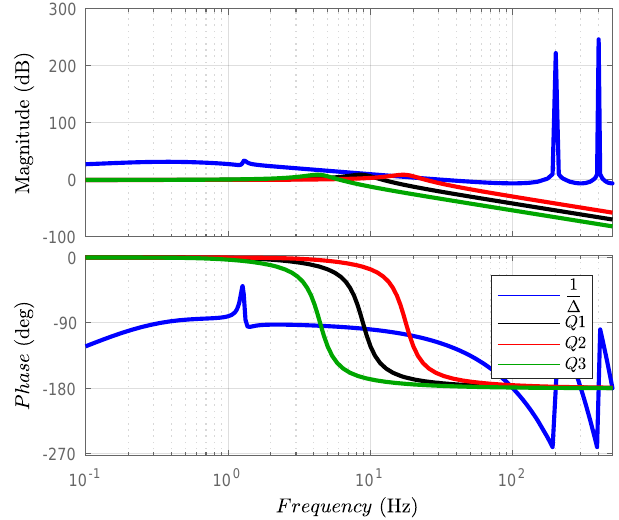
Figure 12. The design of the feedback-loop filter. Since the filter is employed to enhance the closed-loop robustness, the frequency scope of the designed filter should cover the range of bandwidth of the human motion. Moreover, the filter is supposed to remain below and closed to the uncertainties 1/ ∆